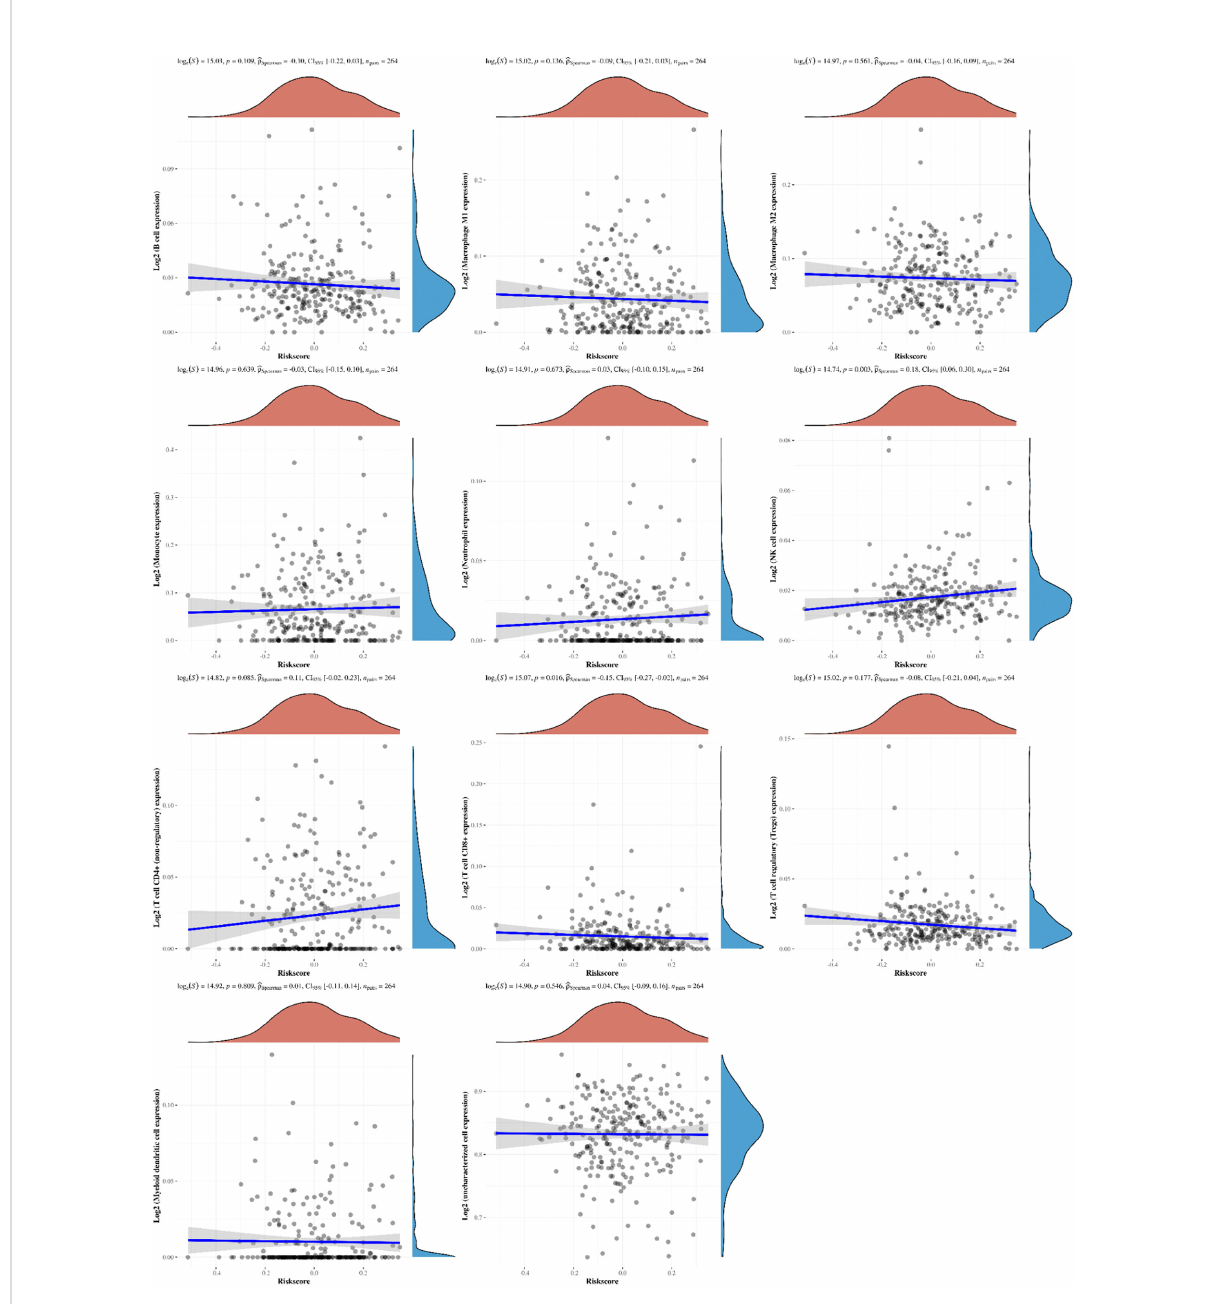
FIGURE 9 The correlations between the Riskscore and different immune cell in fi ltrations. The associations among the Riskscore and in fi ltration of different immune cells, including B cells, M1 macrophages, M2 macrophages, monocytes, neutrophils, NK cells, CD4+ T cells, CD8+ T cells, Treg cells, myeloid dendritic cells, and uncharacterized